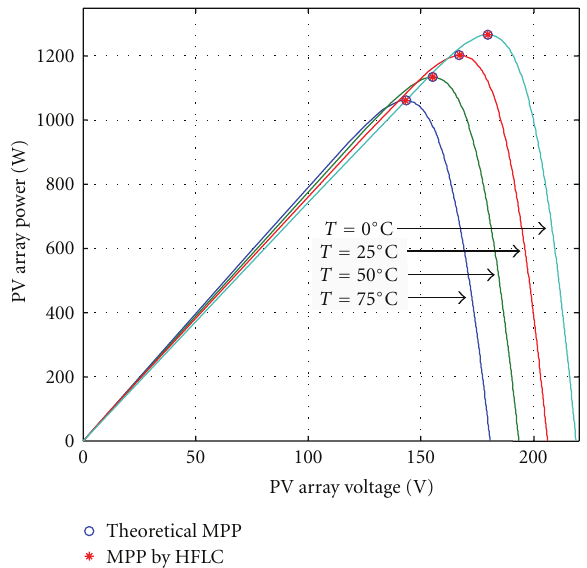
Figure 13: Performance of the HFLC based MPPT under various temperatures at constant irradiation G = 1000W/m 2